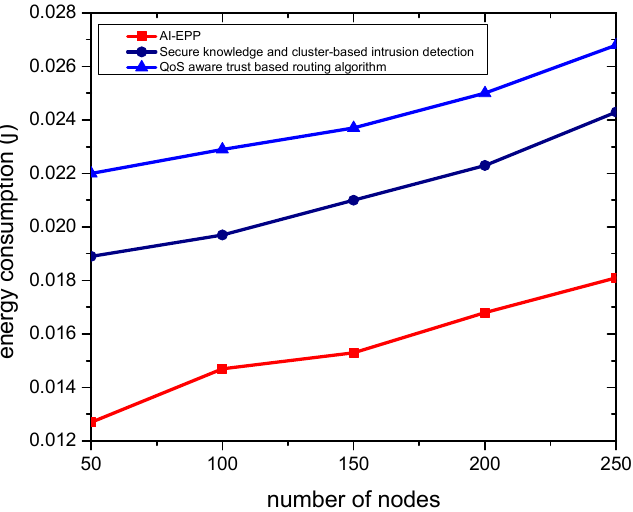
Figure 7. Energy consumption comparison using simulations with varying number of nodes.